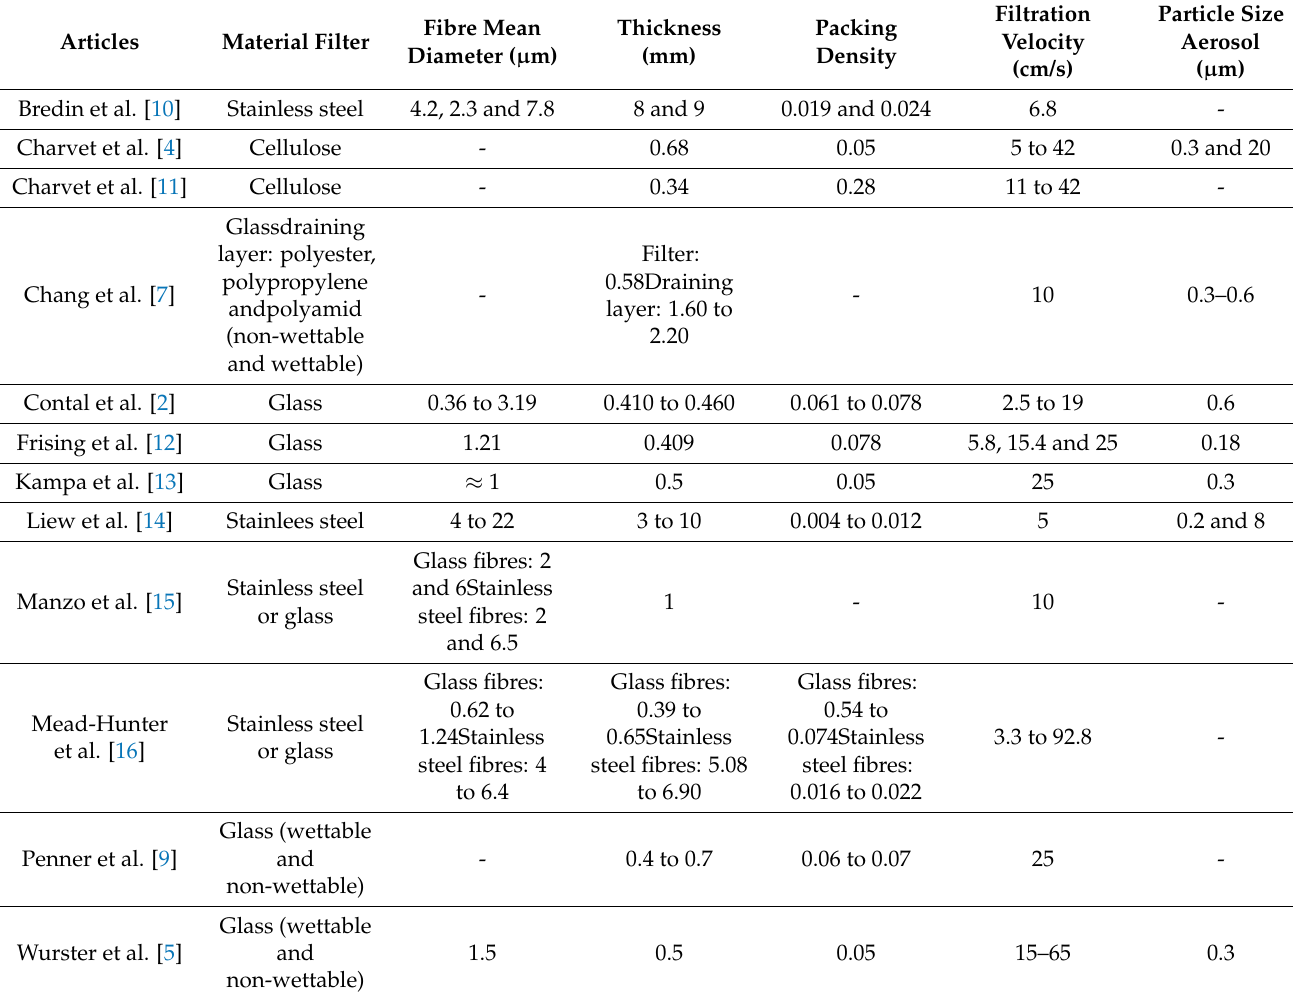
Table 1. Summary of some works on the clogging of filters by liquid aerosol: nature and properties of filters, filtration rate and aerosol